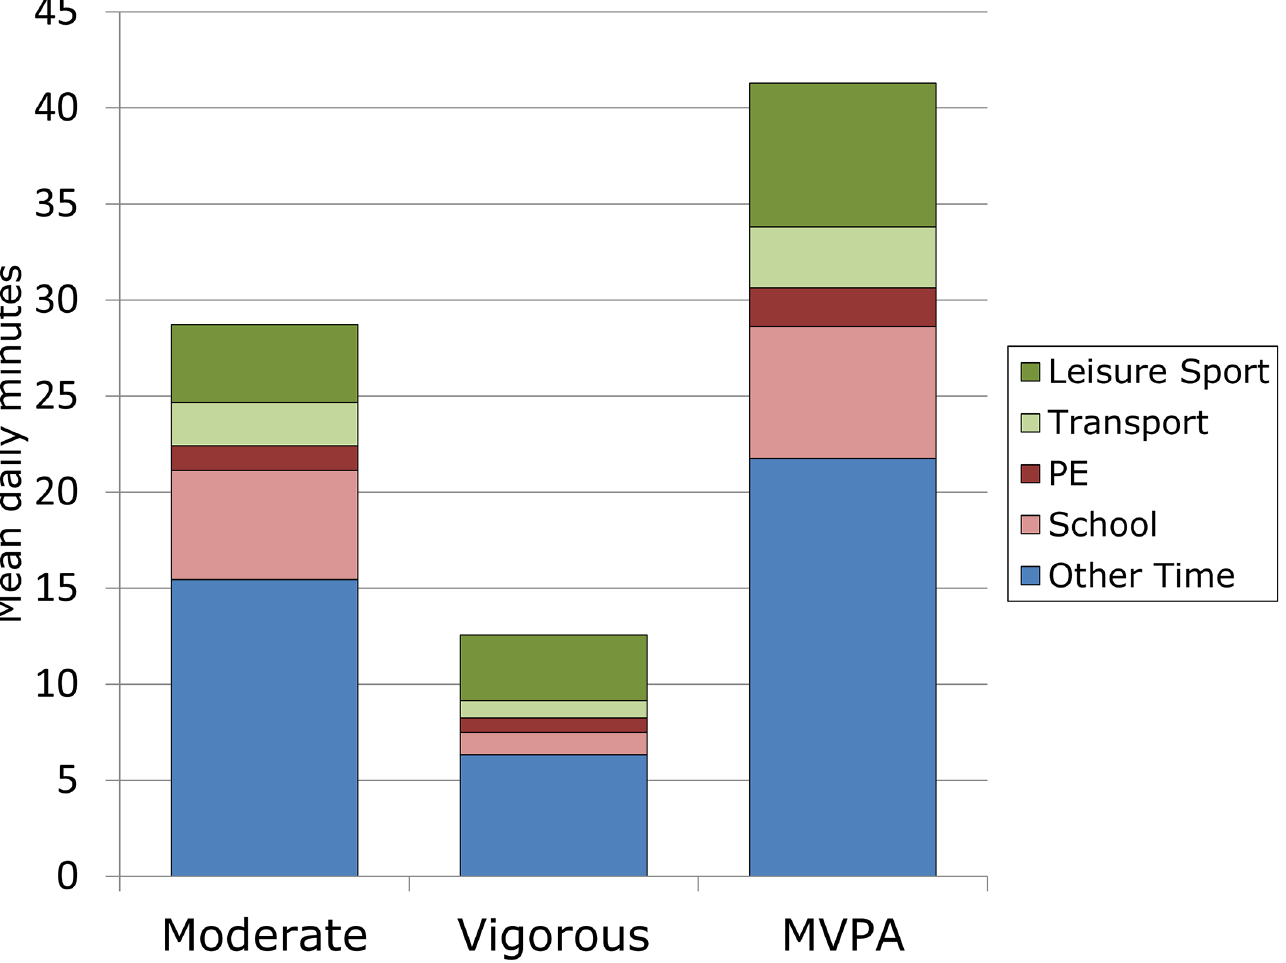
Fig 2. Daily Activity in German Adolescents. PE is any time between diaried start and end of school physical education (PE.) School is any time between diaried start and end of school, outside PE. Leisure Sport is any time outside of PE when the subject diaries sport. Transport is time between leaving home and arriving at school. Only the trip to school is described. Other is all other waking time when the monitor was worn. Estimates for PE and Leisure Sport include estimated moderate and vigorous activity during this period if the diary shows the device was not worn due to sport such as swimming. Calculations are based on data applying Freedson ‘ s vertical-axis algorithm for children from Freedson et al, 2005 [33] as cited in [37]. MVPA is moderate + vigorous physical activity.